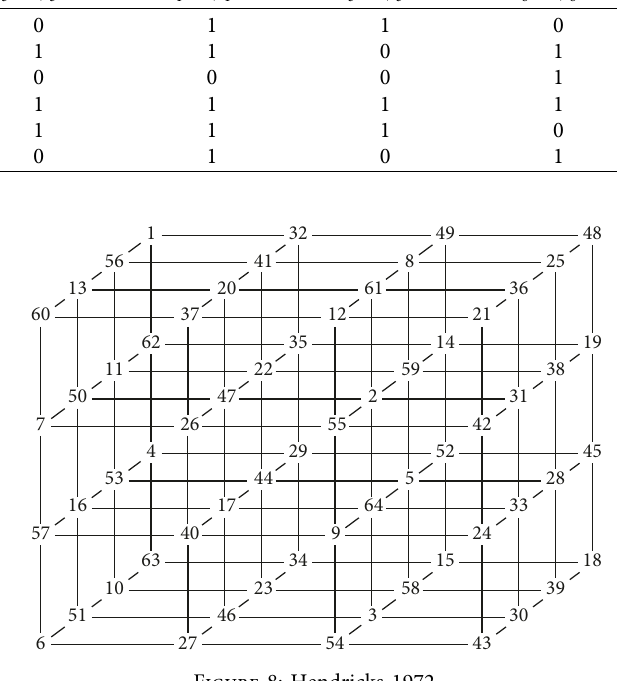
Figure 8: Hendricks